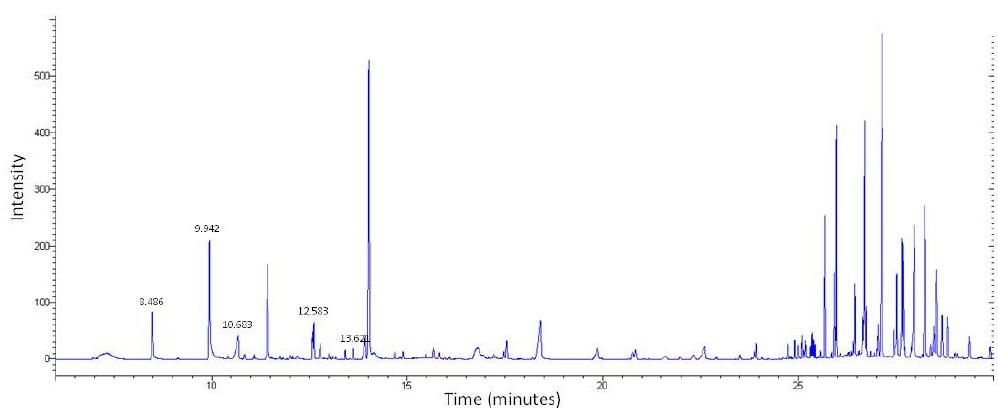
Figure 2. GC–MS profile of SEEP showing the compounds compiled in Table 1. Table 1. Polyphenol and chemical compounds identified in SEEP by LC-MS and GC-MS. (RT: retention time, min; Mw: molecular weight; m / z : mass to charge ratio). The compounds highlighted in bold have been previously found in olive oil.